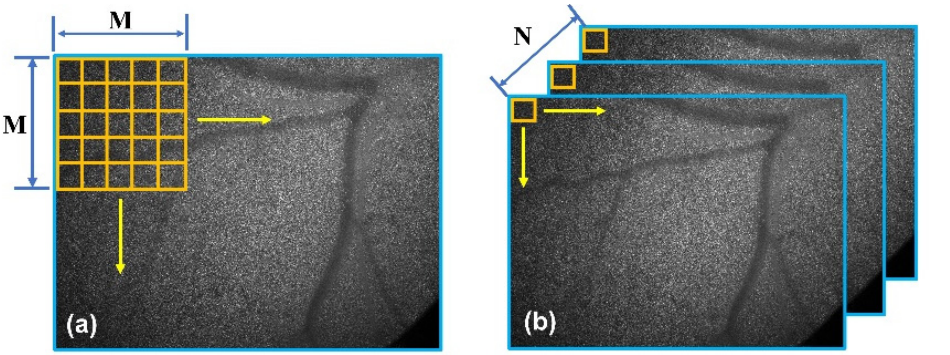
Figure 4. Schemas of the sLSCI and tLSCI (blue arrow: the number of pixels of the original speckle image required for contrast analysis, red arrow: ergodic direction for contrast analysis). ( a ) sLSCI, ( b ) tLSCI.